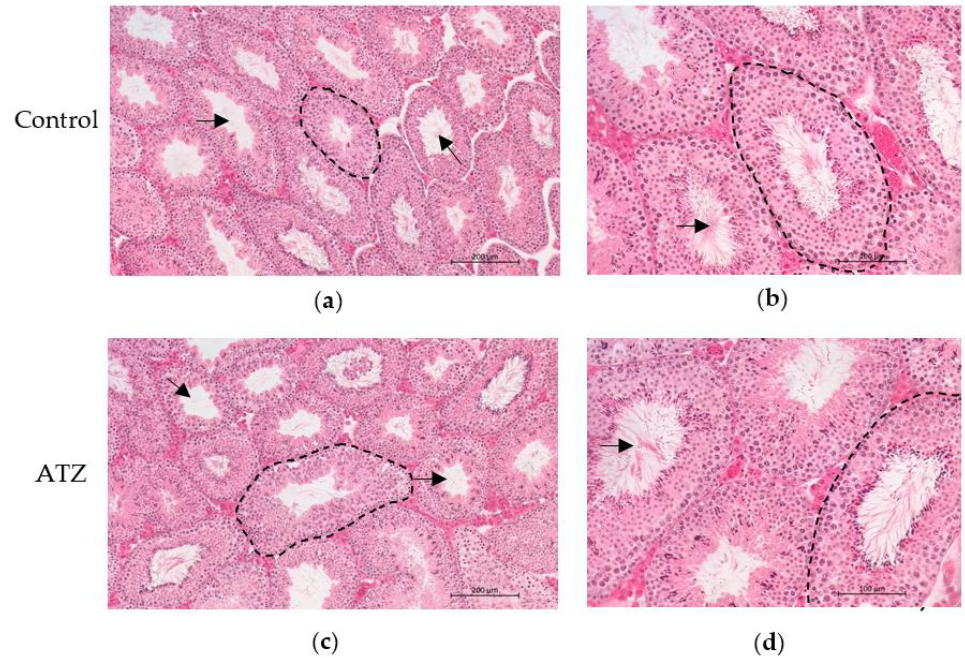
Figure 1. Representative images of H&E-stained testis section from F1 mice exposed to 0.02 ng/mL atrazine or the control for 6 months. ( a ) control ( × 100), ( b ) control ( × 200), ( c ) ATZ ( × 100), ( d ) ATZ ( × 200). No visual difference in gross morphology was observed between treatment groups. Scale bar at 100 × is 200 µ m, and at 200 × is 100 µ m. Arrow indicates the tubule lumen and the dashed line indicates the basement membrane of the tubule.